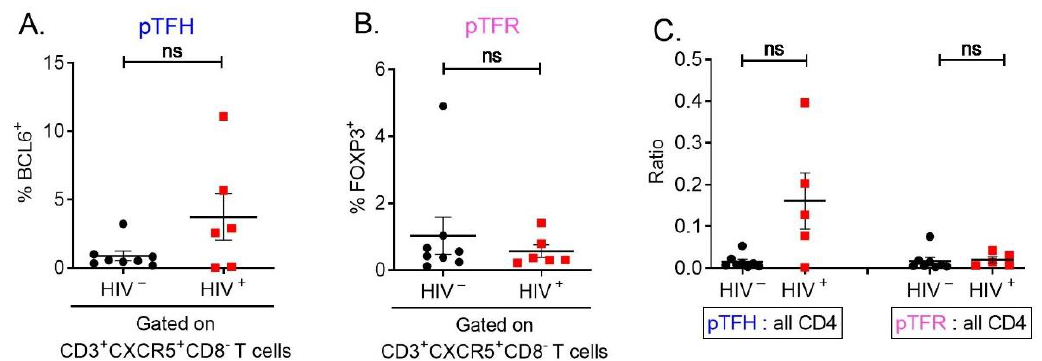
Figure 4. pTFH-cell frequency increases upon HIV infection, but pTFR-cell frequency does not. Viably frozen PBMCs from the MACS were thawed and immunophenotyped for pTFH and pTFR cells. ( A , B ) pTFH cells were characterized as FOXP3 - BCL6 + CD3 + CXCR5 + CD8 − CD4 + and pTFR cells as FOXP3 + CD3 + CXCR5 + CD8 − CD4 + . ( C ) pTFH and pTFR cells frequency was compared relative to